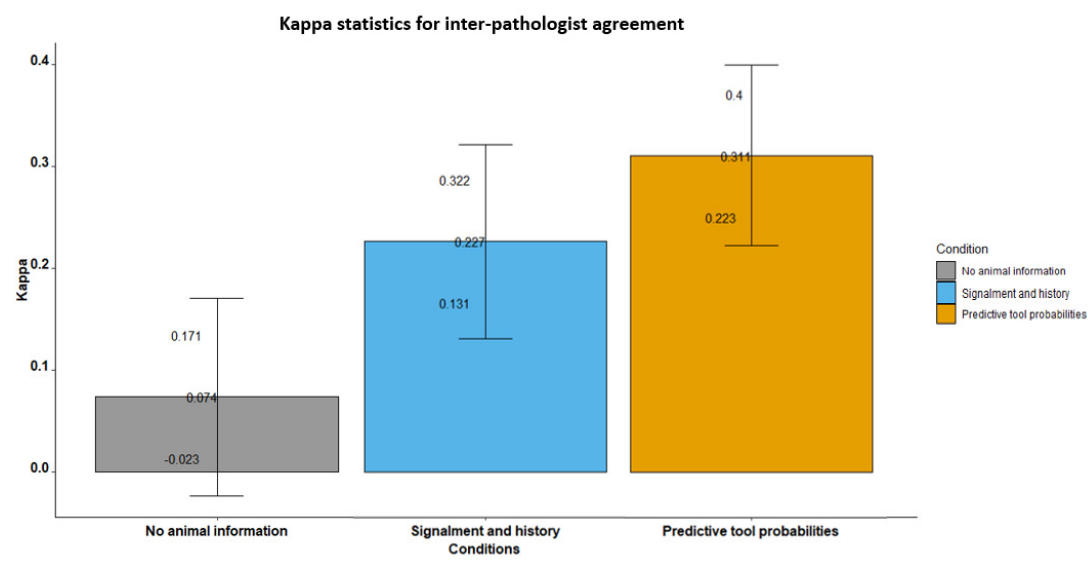
Figure 2. Bar plot showing the inter-pathologist agreement kappa statistics with 95% CI for the three slide-reading conditions, diagnosing digital slides of canine and feline bladder tissue.